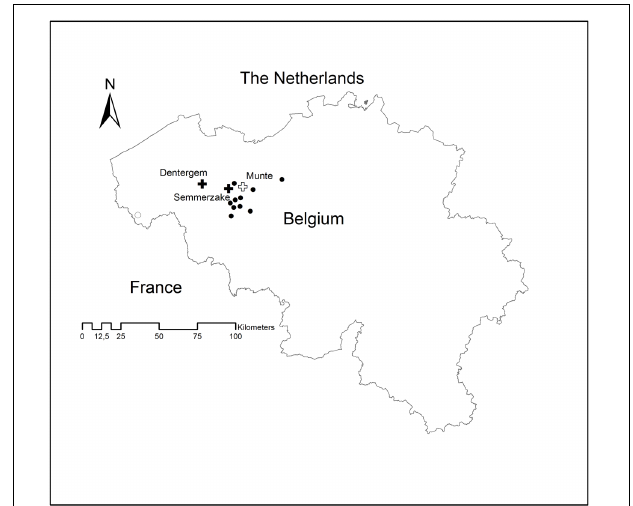
FIGURE 1 | Map showing the locations of the source populations and the three plantations. Filled circles: source populations for the clone plantations; open circle: source population for the family plantation; filled cross: clone plantations (Dentergem and Semmerzake); open cross: family plantation (Munte).